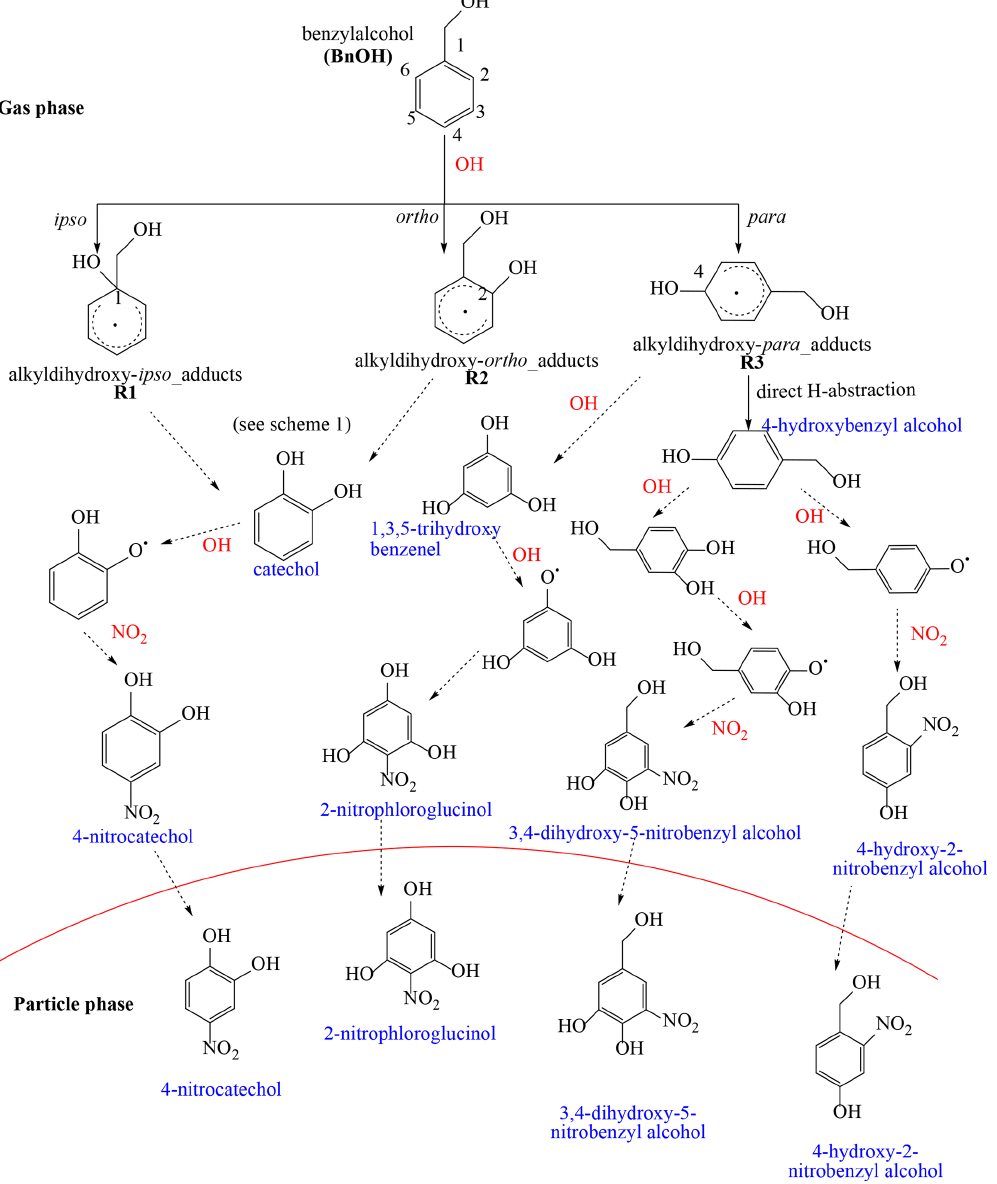
Scheme 2. Proposed mechanism for selected NAC species observed in this